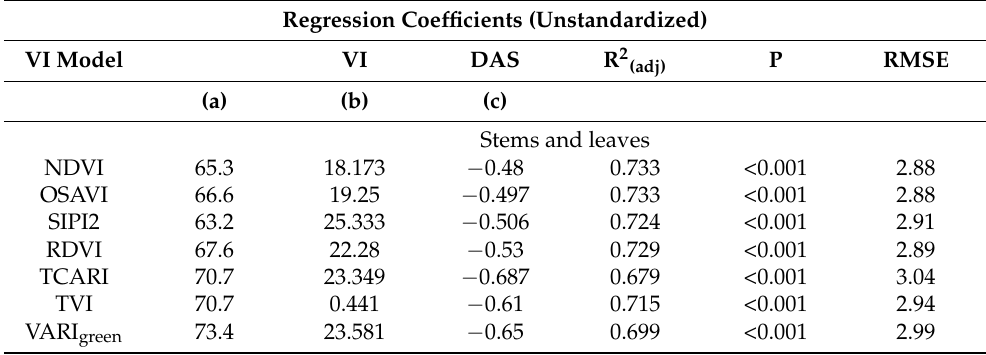
Table 3. Results of the linear regression analysis for predicting stems/leaves or capsules moisture content (MC) from vegetation indices (VI) and the days after spraying